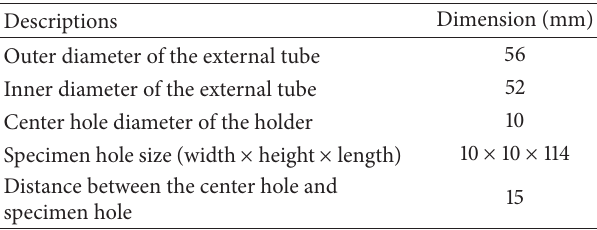
Table 1: Geometrical data of the standard